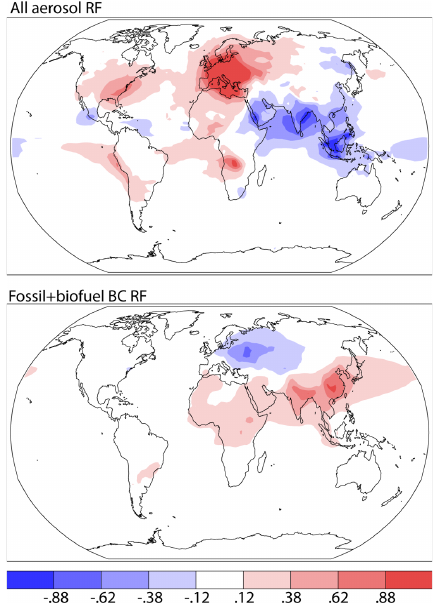
Fig. 13. Multi-model mean difference in all aerosol RF and in fossil + biofuel BC RF between 2000 and 1980 for models with re- sults available at both times.